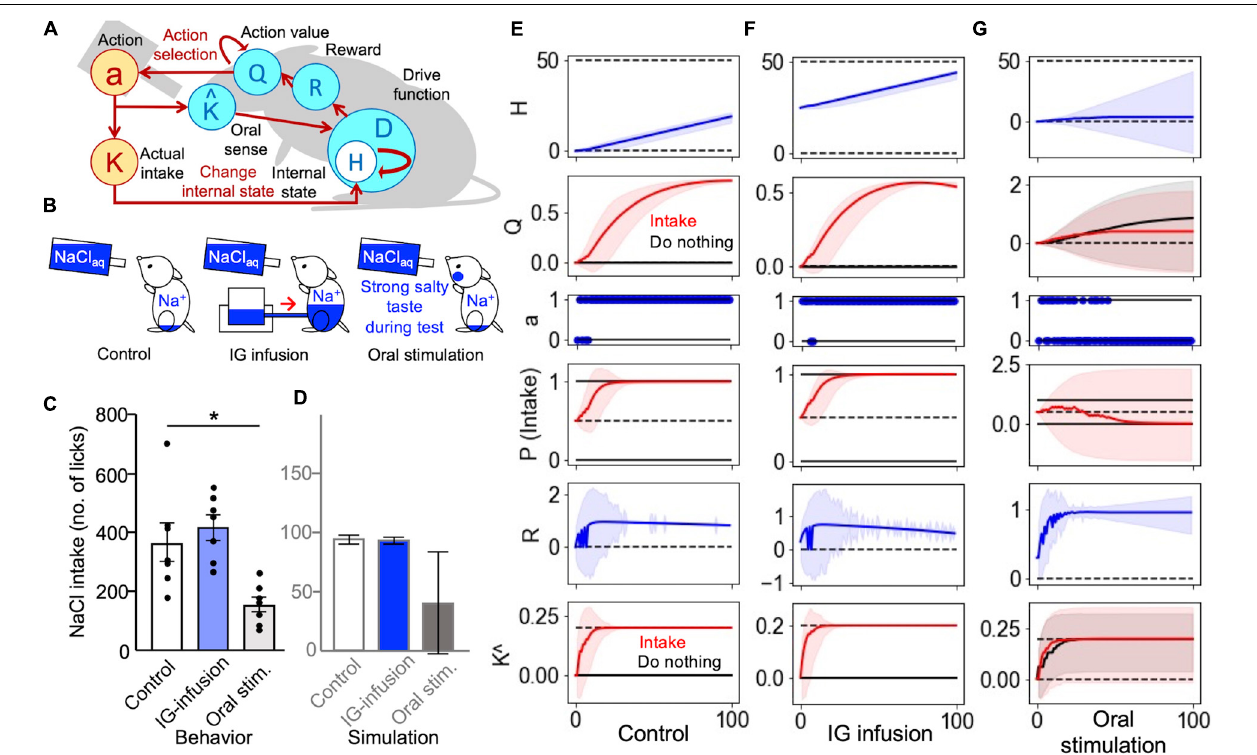
FIGURE 2 | Intragastric and oral stimulation tests were explained using the sense of taste as a predictor of changes in the internal state. (A) Schematic illustration of Simulations 2 and 3: Taste perception ( K ˆ) was a predictor of an increase in the internal state. (B) Three groups for the behavioral tests. (C) The results of the behavioral experiment (Lee et al., 2019). * P < 0.05. (D) The results of the computational model. Intragastric infusion did not change the level of sodium intake, while oral stimulation decreased intake. (E–G) Transitions of the simulation. (E) The control group exhibited an increased Q -value for intake. (F) A congenial increase in the Q -value was observed in the IG-infusion group. (G) The values of “do nothing” and “intake” were reinforced in the oral-stimulation group. (E–G) The solid lines represent the results of a trial, and the light-colored error ranges represent the mean ± 2 SD of 100 simulated